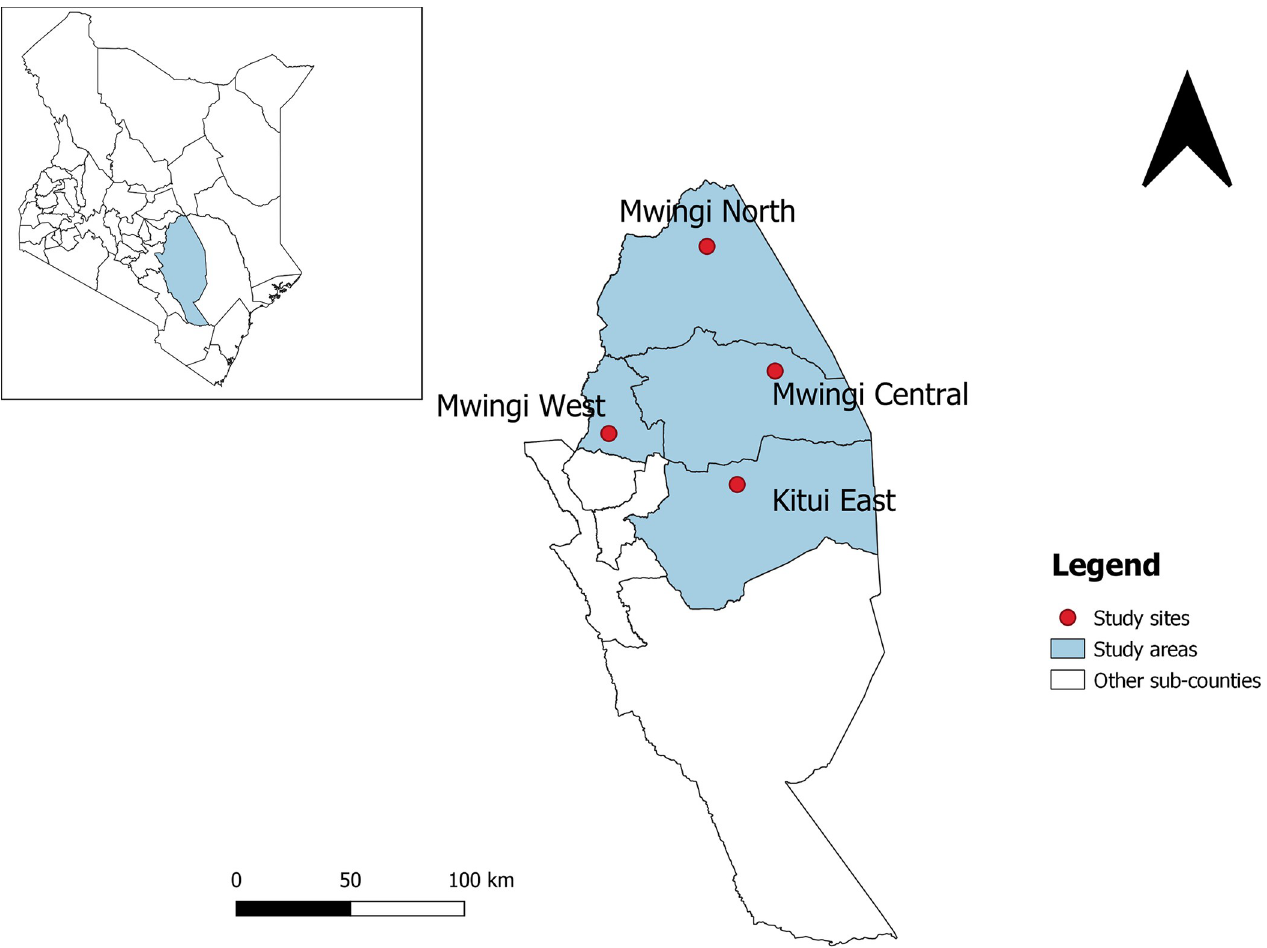
Fig 1. Map of Kitui county showing the study areas and sites (Created using the Free and Open Source QGIS v3 . 22 . 3) .